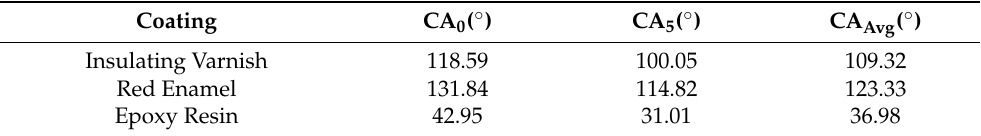
Table 3. Contact angle at time 0 and 5 min (CA 0 and CA 5 ) for insulating varnish, red enamel, and epoxy resin.